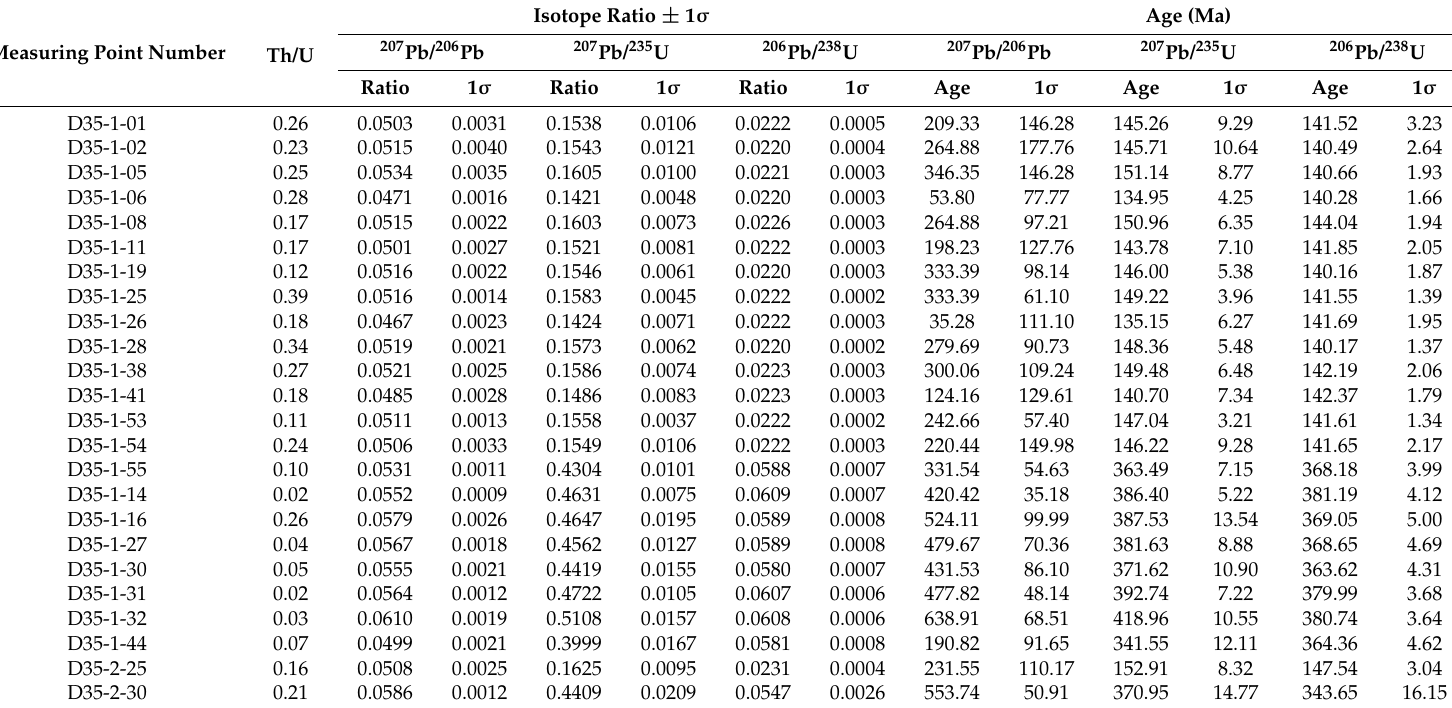
Table 2. LA-ICP-MS zircon U-Pb dating results of porphyritic granites in Dongping gold